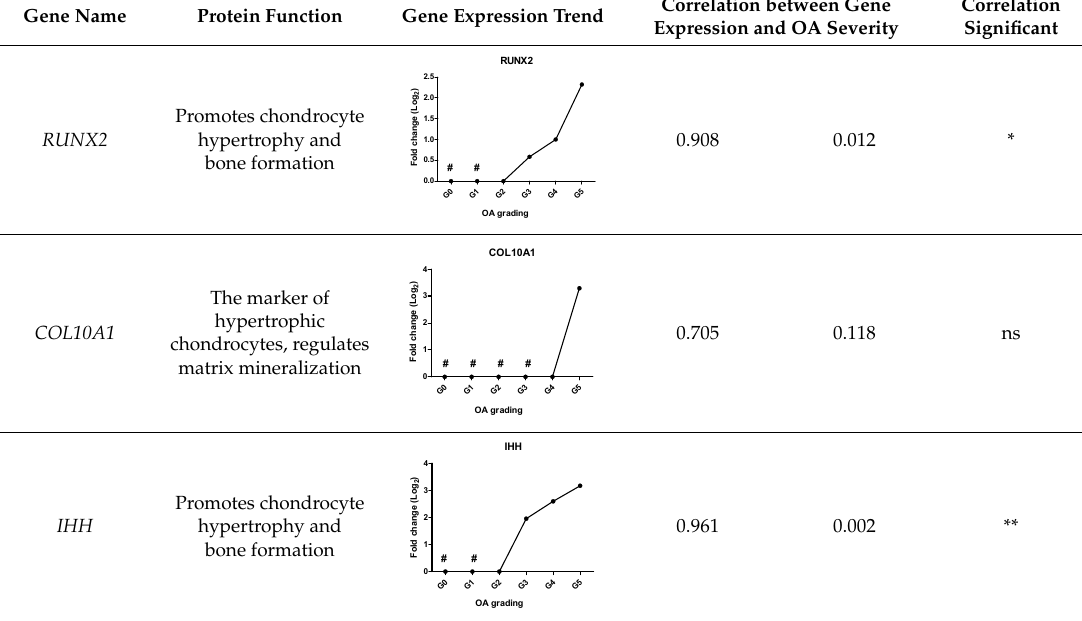
Table 2. Expression of hypertrophy-related genes in OA cartilage and correlation with the severity of OA ( n = 12). RT-PCR was performed to assess gene expression. Pearson correlation was used to examine the correlation between gene expression and the severity of OA. Y axis = 0, indicated by #, means this gene is under the detection level. p < 0.05 was considered statistically correlated. ns: no correlation; * p < 0.05, ** p < 0.01: significant